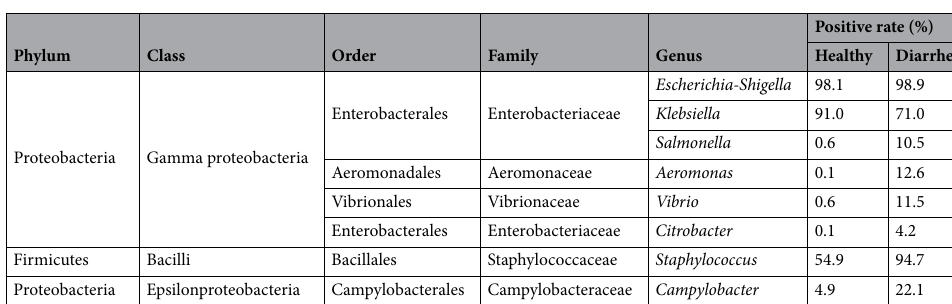
Figure 4. Comparison of fecal microbiota between adult patients with diarrhea and healthy controls. Identification of difference of bacterial markers in gut microbiota between adult patients with diarrhea and healthy controls using LEfSe analysis ( A ) and LDA score > 3.0 ( B ). The cladogram was calculated and depicted by LEfSe, a major metagenomic analysis method. The effect size of each taxon or OUT with different quantities was evaluated by Wilcoxon sum-rank test followed by liner discriminant analysis.